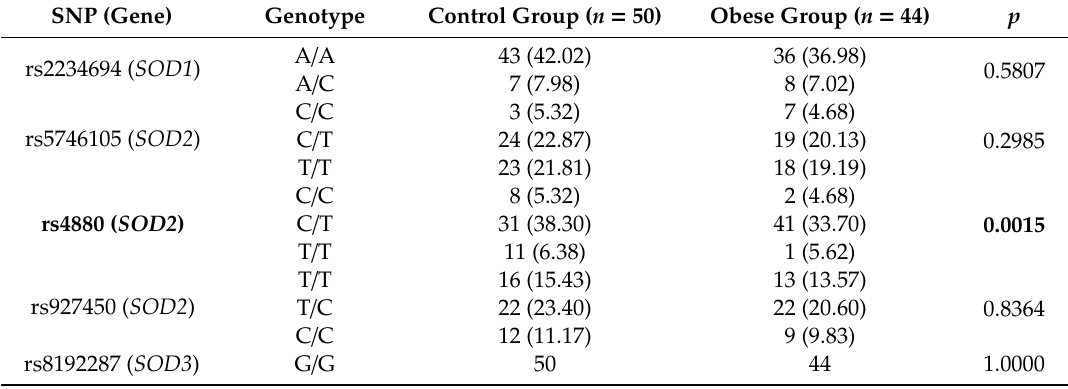
Table 8. Contingency table of genotype distribution of the selected single nucleotide polymorphisms (SNPs), in context of